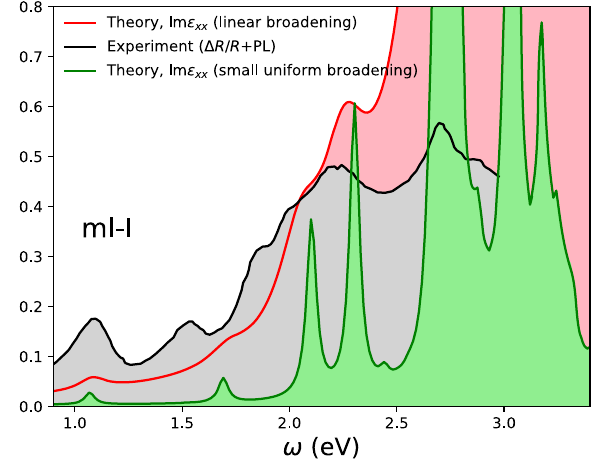
Fig. 4 Benchmarking against experimental optical absorption in monolayer CrI 3 . Comparison between the adopted differential re fl ectivity data combined with low-energy photoluminescence data from the recent experimental work on ml-CrI 312 against our theoretical Im ϵ xx results. The theoretical spectra for Im ϵ xx are rigidly blue-shifted slightly as our exciton peaks from v 24 c 14 were by ~0.2 eV too deep compared to experiments. The theoretical data for different optical broadening schemes are also plotted on top of the adopted experimental